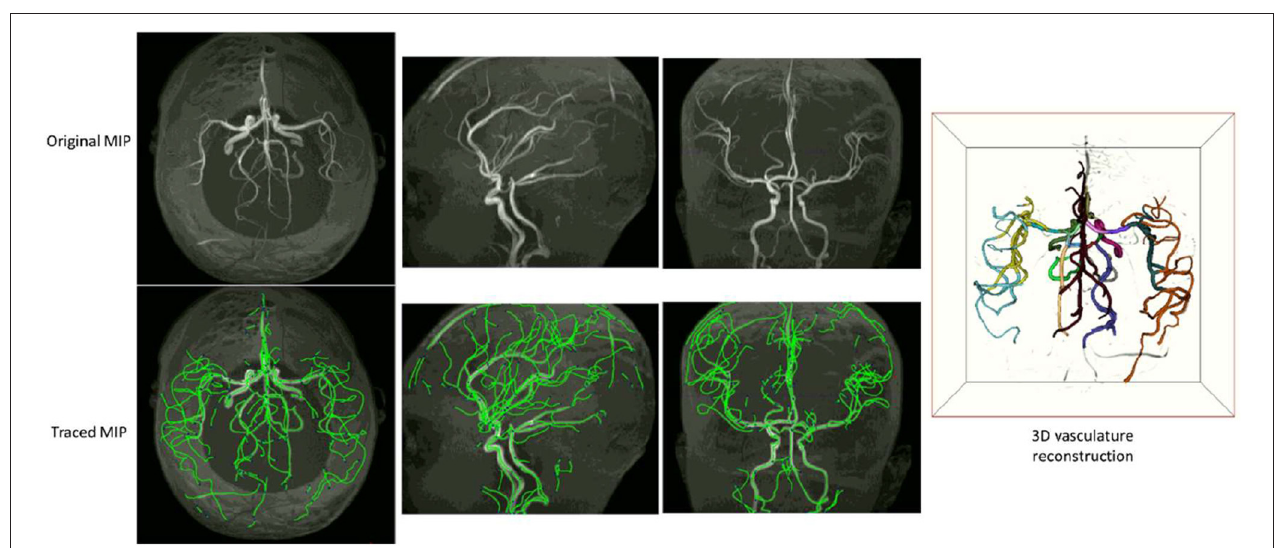
Frontiers in Neurology |